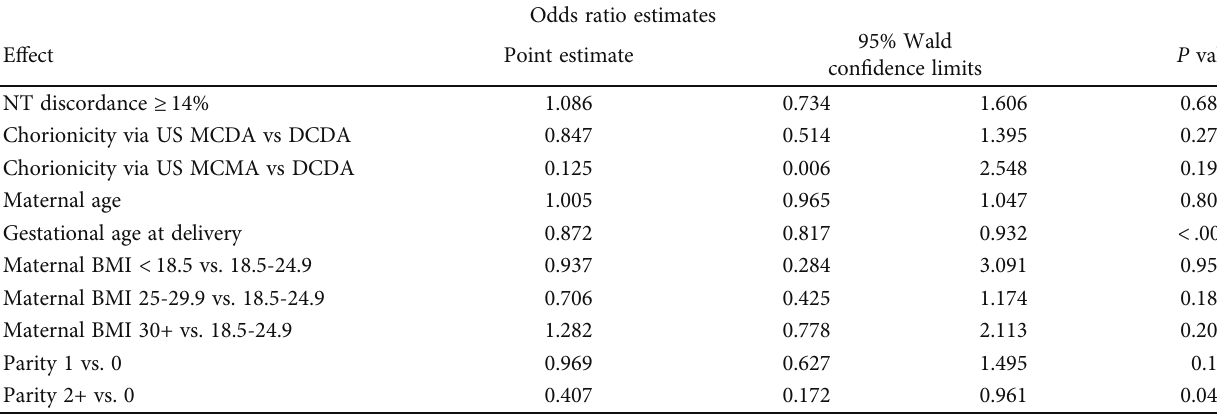
Table 4: Multivariate probability modeling the e ff ect of NT discordance >/ = 14 % on birth weight discordance.